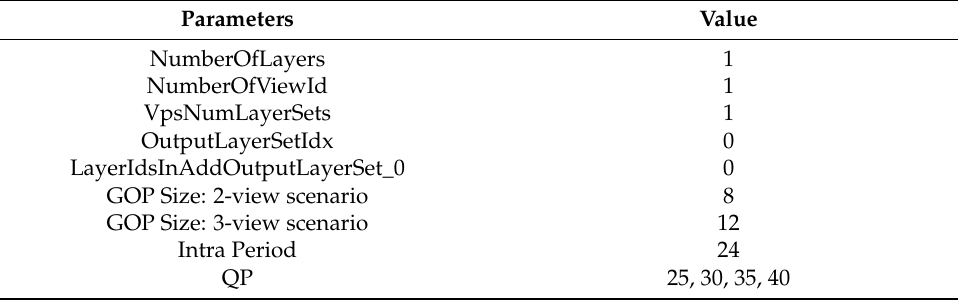
Figure 3. Reference frame architecture of the proposed HEVC-FISMVC for multiview videos. Table 1. MV-HEVC design parameter for the proposed codec.